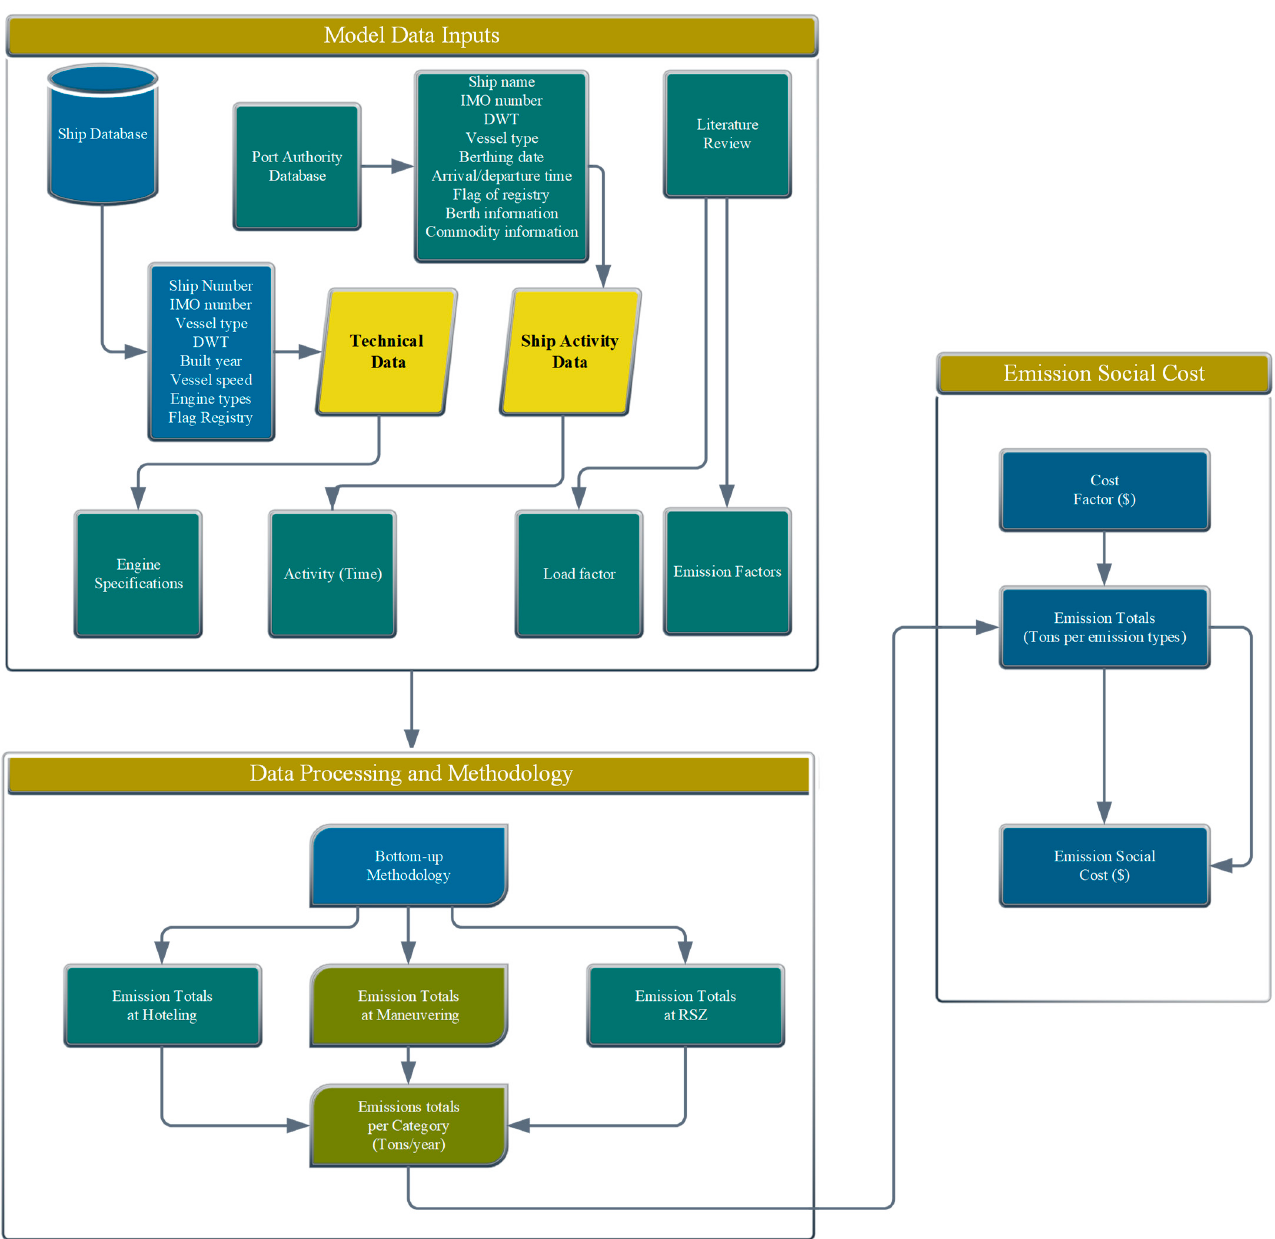
Figure 2. Schematic diagram of the study.